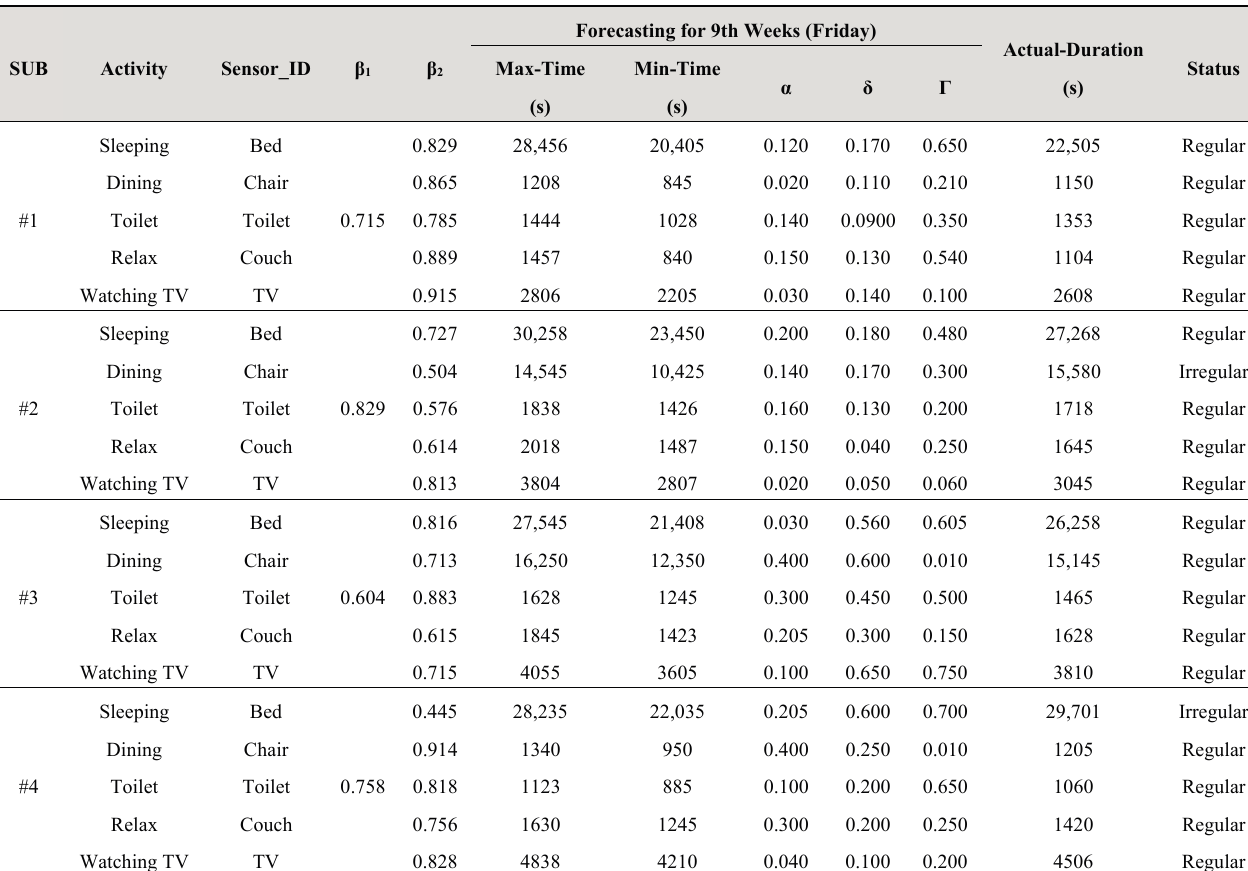
Table 1. Wellness function indices of household appliances and forecast of the ADLs